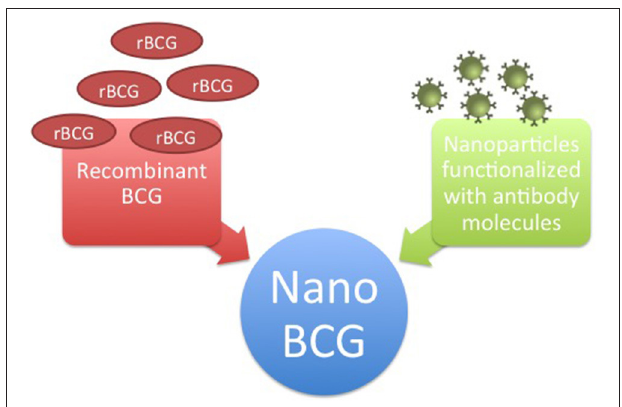
FIGURE 1 | Combination of therapeutic approaches for bladder cancer treatment. Nano BCG has gain of effect by combination with recombinant BCG or by functionalization of nanoparticles with antibodies